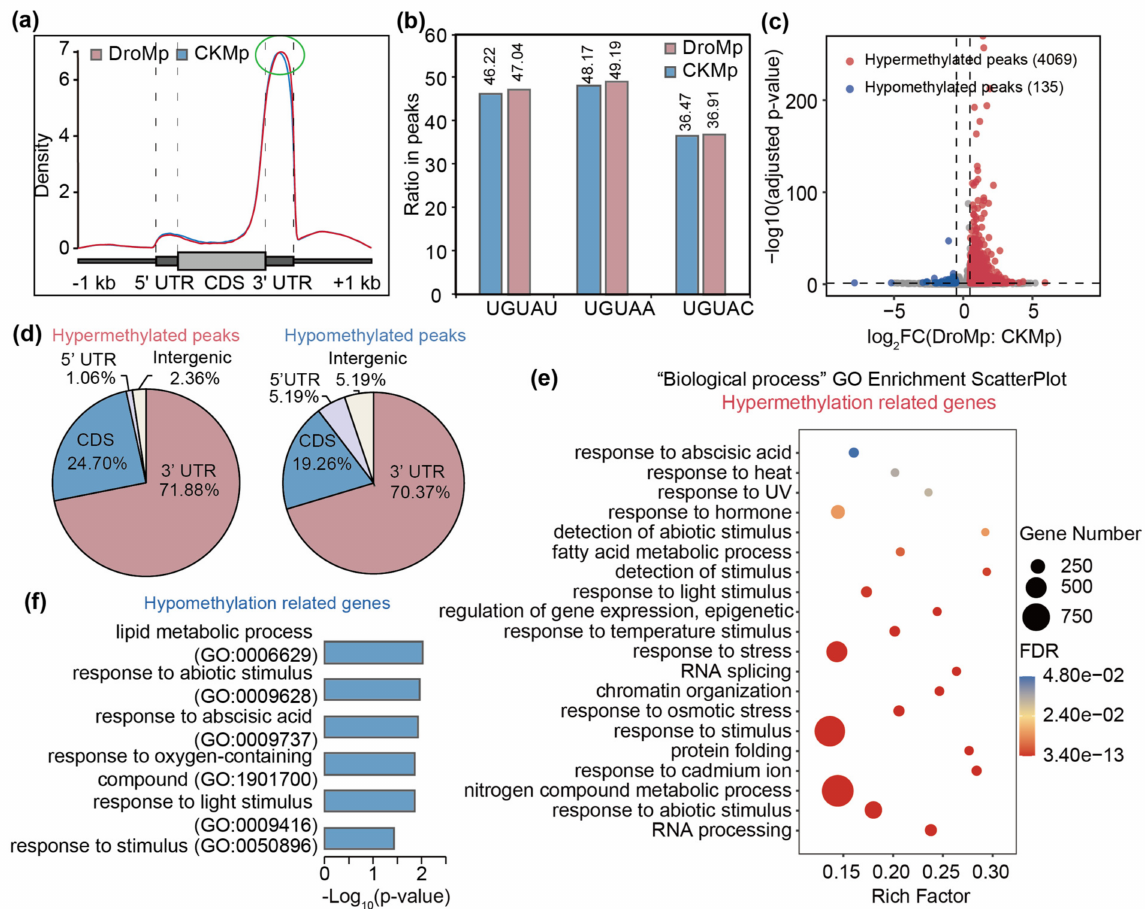
Figure 3. Differential m 6 A modifications in Malus prunifolia seedlings in response to drought. ( a ) Density of m 6 A peak distribution along transcripts of Malus prunifolia seedlings in response to drought conditions. The area circled in green shows the difference in density between the two groups. ( b ) Percentage of UGUAH (H: A/U/C). ( c ) Volcano plot showing hypermethylated and hypomethylated m 6 A peaks. ( d ) Pie charts showing the m 6 A peaks distribution within transcripts. ( e ) GO enrichment analysis of hypermethylated peak-related genes. ( f ) GO enrichment analysis of hypomethylated peak-related genes. DroMp, M. prunifolia seedlings were treated with drought stress; CKMp, M. prunifolia seedlings were grown under control condition; CDS, coding sequence; UTR, untranslated region; FDR, false discovery